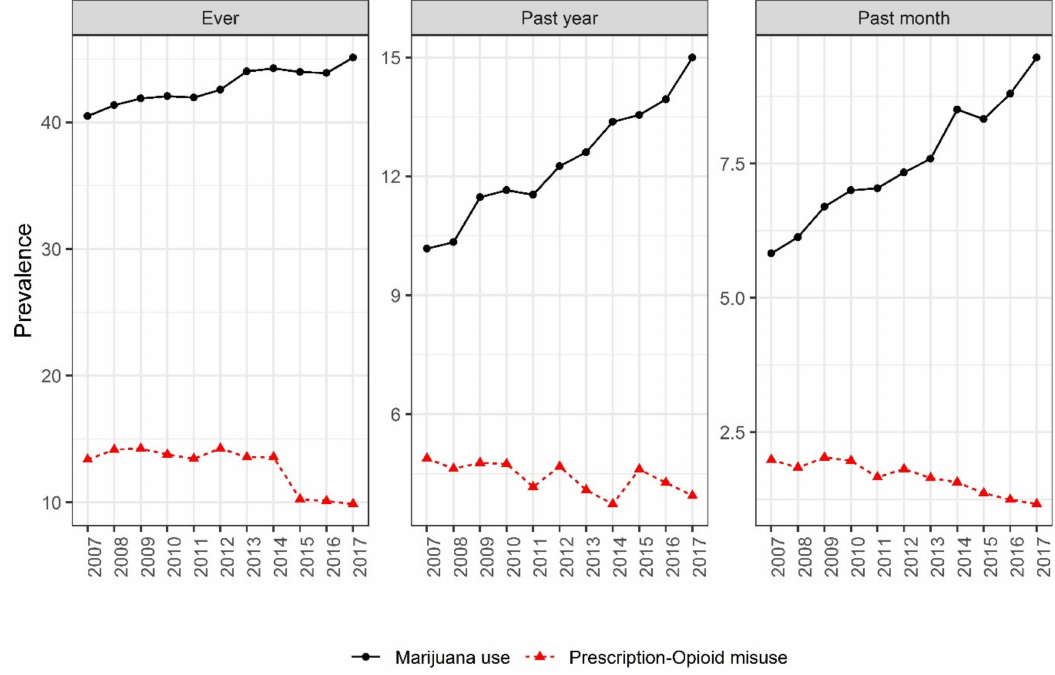
Figure 1. Prevalence of marijuana use and prescription-opioid misuse in the United States, 2007–2017. Cochran–Armitage tests were used to assess the statistical significance of changes over time ( p <